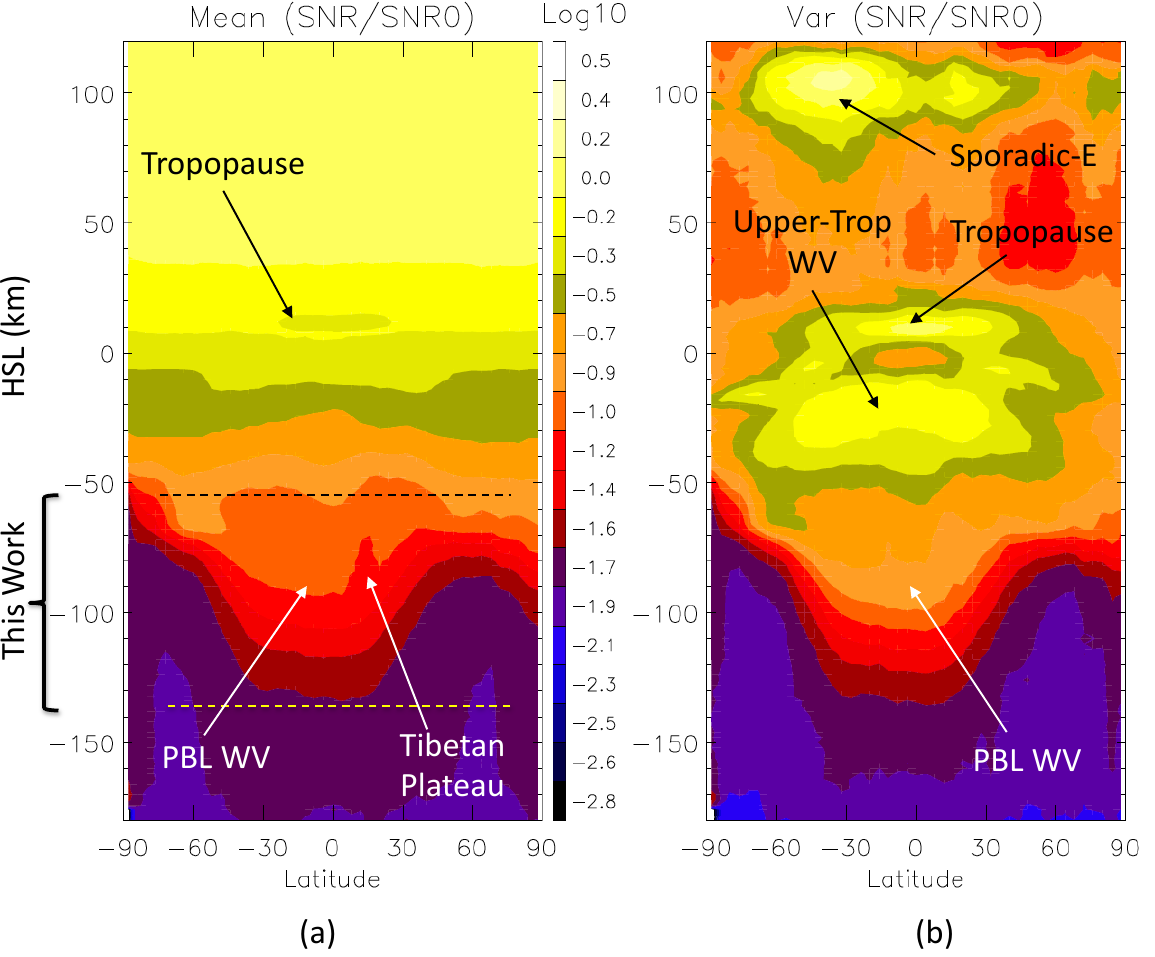
Figure 2. ( a ) Zonal mean S RO and ( b ) σ 2 from COSMIC-1 for January 2008 as a function of latitude and H SL , showing enhanced SNR at deep H SL from ABL q and increased variances from layered regions. A significant reduction from the Tibetan Plateau is reflected in zonal mean S RO